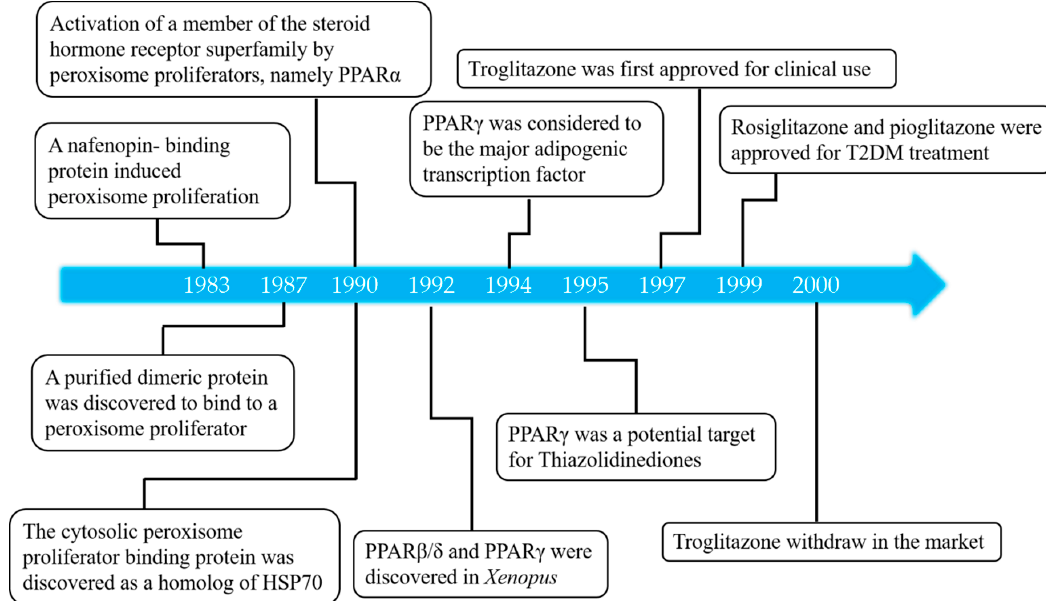
Figure 1. Discovery of the PPARs. Landmark events in the advancement of PPARs research.